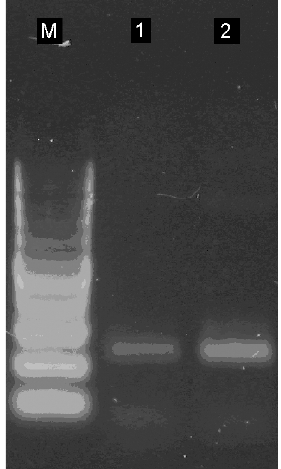
Figure 7. Comparison of the usage of commercial adsorbent (line 1) and synthesized silica-magnetite nanocomposite (line 2) for isolation of virus DNA fragments from sugar beet using agarose gel electrophoresis. Line M–DNA markers [100].